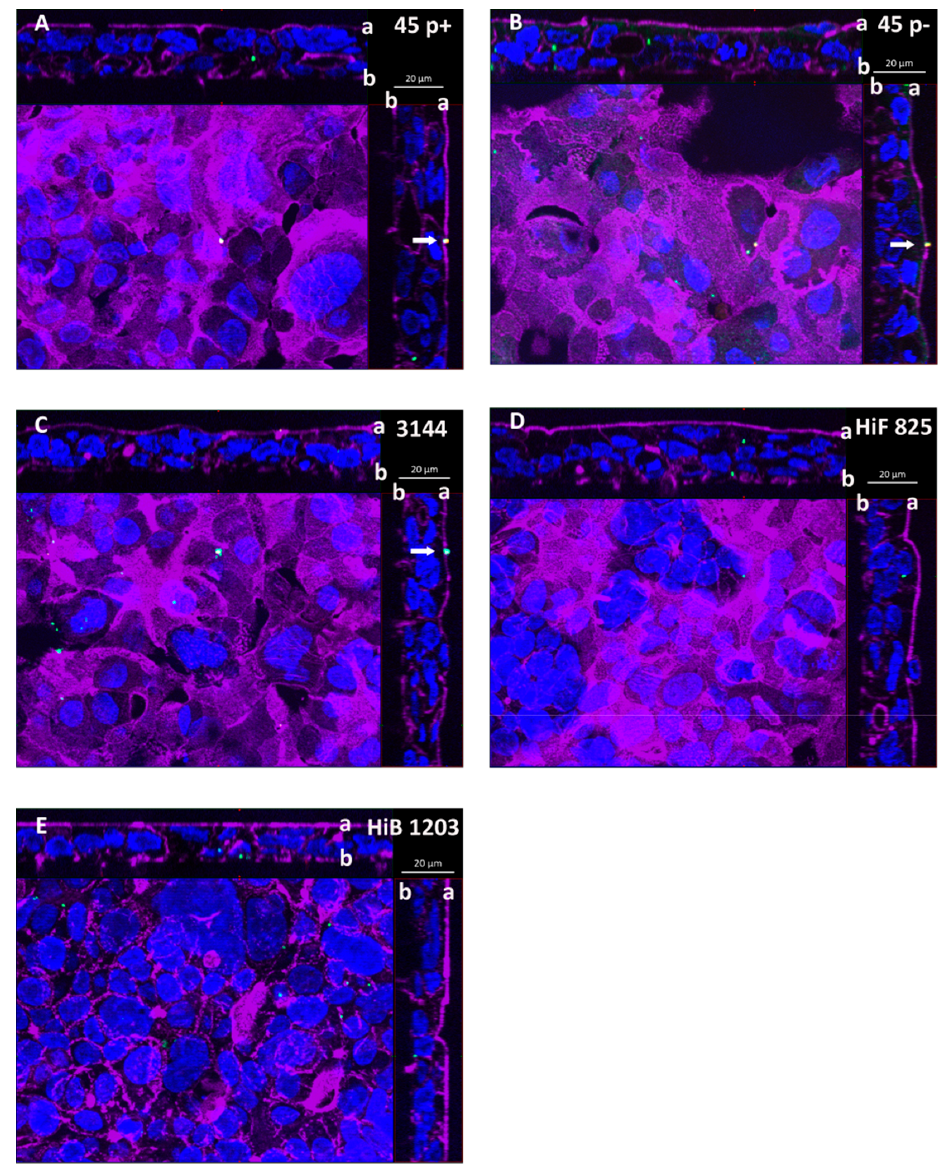
Figure 3. DIF sections of HIBCPP cells depicting cells basolaterally infected with the indicated Haemophilus strains. Cells were grown in the inverted cell culture system and challenged with a MOI of 20 of: ( A ) the nasopharyngeal NTHI isolate 45 p+ (fimbriated variant); and ( B ) the nasopharyngeal NTHI isolate 45 p- (non-fimbriated variant); ( C ) the NTHI CSF isolate 3144; and the encapsulated H. influenzae CSF isolates ( D ) HiF 825 and ( E ) HiB 1203. After 6 h of infection, cells were subjected to DIF staining to analyze invasion. Intracellular bacteria are visualized in green and extracellular bacteria in yellow. DAPI (blue) and phalloidin (purple) were used to stain the cell nuclei and the actin cytoskeleton, respectively. ( A – E ) Apotome images of basolaterally infected HIBCPP cells. The center part of each panel represents the xy en face view. An overlay of selected slices through the z-axis intensifies images for presentation. The top and side parts of each panel represent the cross-sections through the z-plane of slices in the overlay. In the cross sections, the apical cell side facing the top and the right side, respectively, is labeled with “a” and the basolateral cell side facing the center part is labeled with “b”. A characteristic distribution for the individual strains is represented. Invaded bacteria (green) appear as single specimen. Extracellular bacteria (yellow) adhering to the apical cell side are marked with a white arrow. These bacteria represent specimen that have transmigrated through the HIBCPP cell layer from the basolateral side still being attached to the apical cell